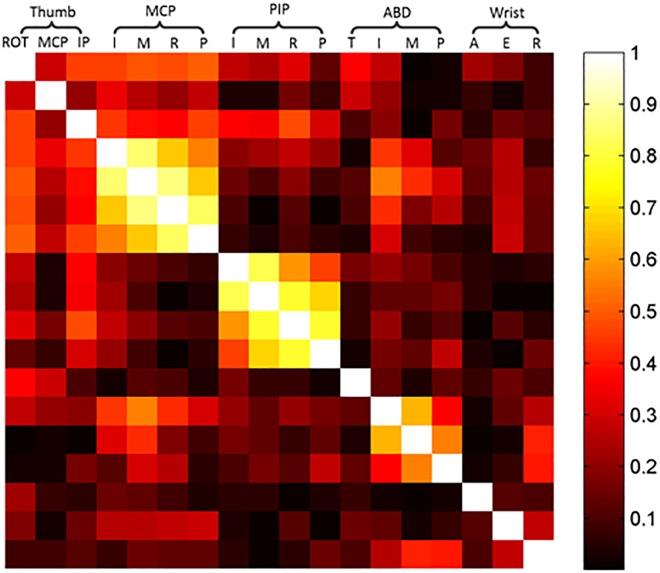
Correlation coefficients between 18 joint angles of hand and wrist.The gray scale in each square denotes the absolute coefficient of determination (r2) for the relation between the angles.